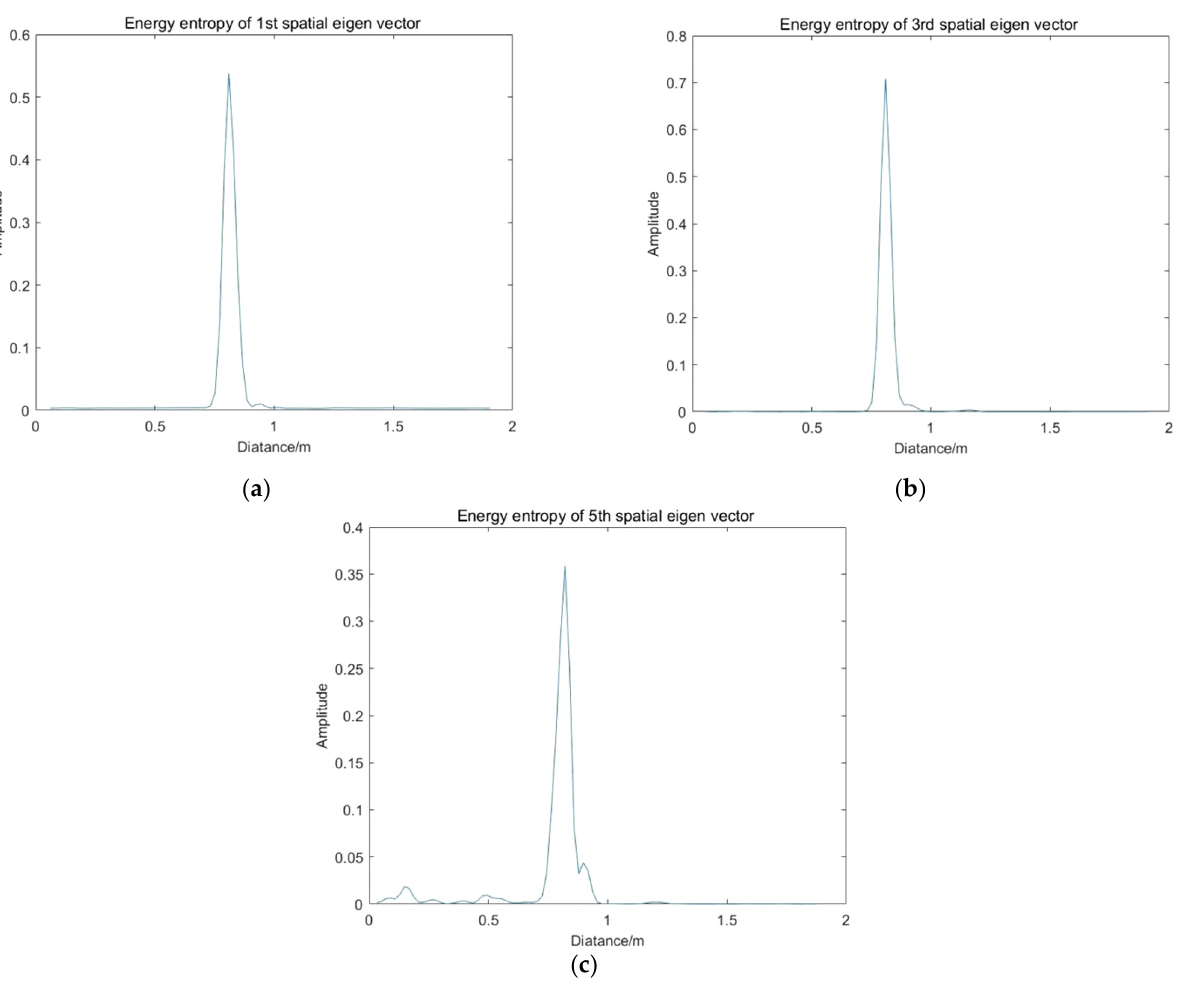
Figure 16. Energy entropy of each order principal component at different positions: ( a ) Energy entropy of first spatial eigenvector; ( b ) Energy entropy of third spatial eigenvector; ( c ) Energy entropy of fifth spatial eigenvector.